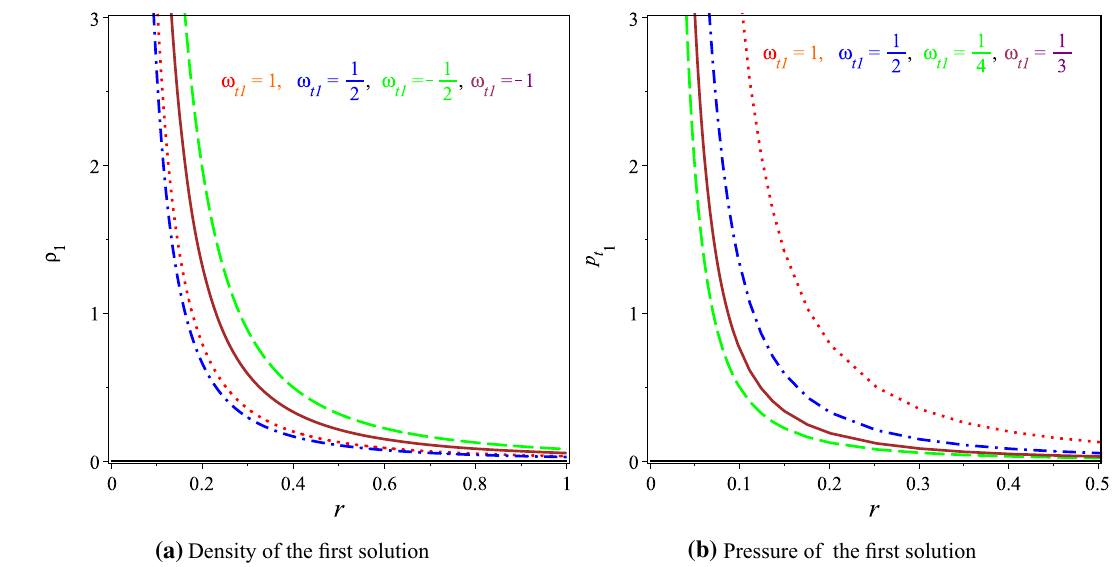
Fig. 1 Schematic plot of the radial coordinate r in the unit of km versus the energy density and pressure of the solution (18)